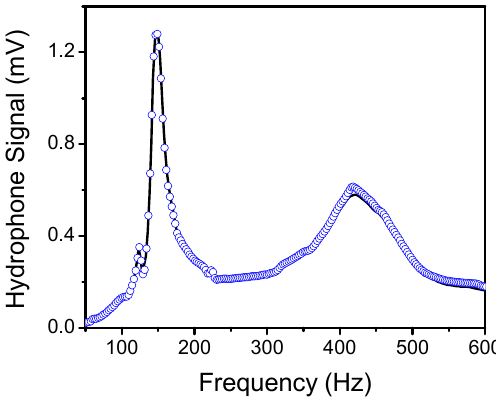
Figure 4. Measured frequency response of the sound projector using a calibrated hydrophone with (blue circles) and without (black line) the boot attached to it.